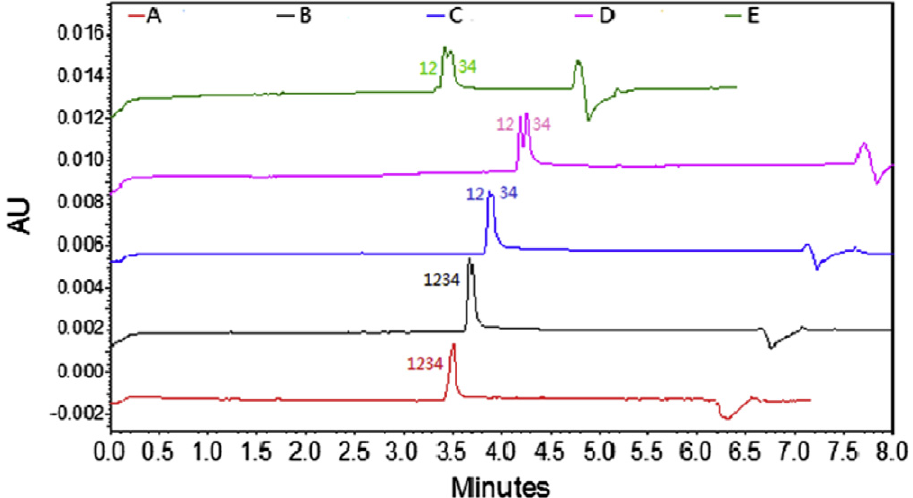
Figure 4. Ionic liquid [TBA][L-ASP] concentration effect. Peaks: cinchonidine (1), quinine (2), cinchonine (3), quinidine (4). (A) 1 mM, (B) 4 mM, (C) 8 mM, (D) 16 mM, (E) 20 mM. Reprinted with permission from Ref. [38].